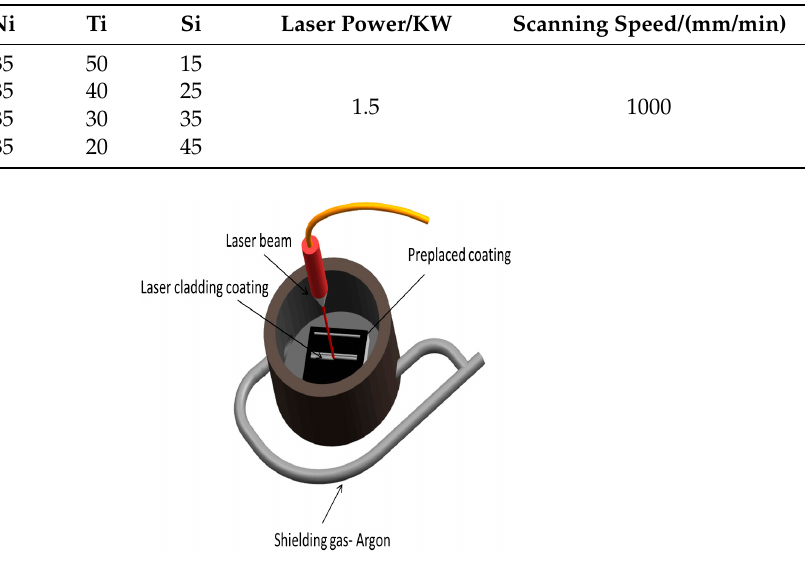
Table 2. The chemical composite of cladding powders (at %) and processing parameter.